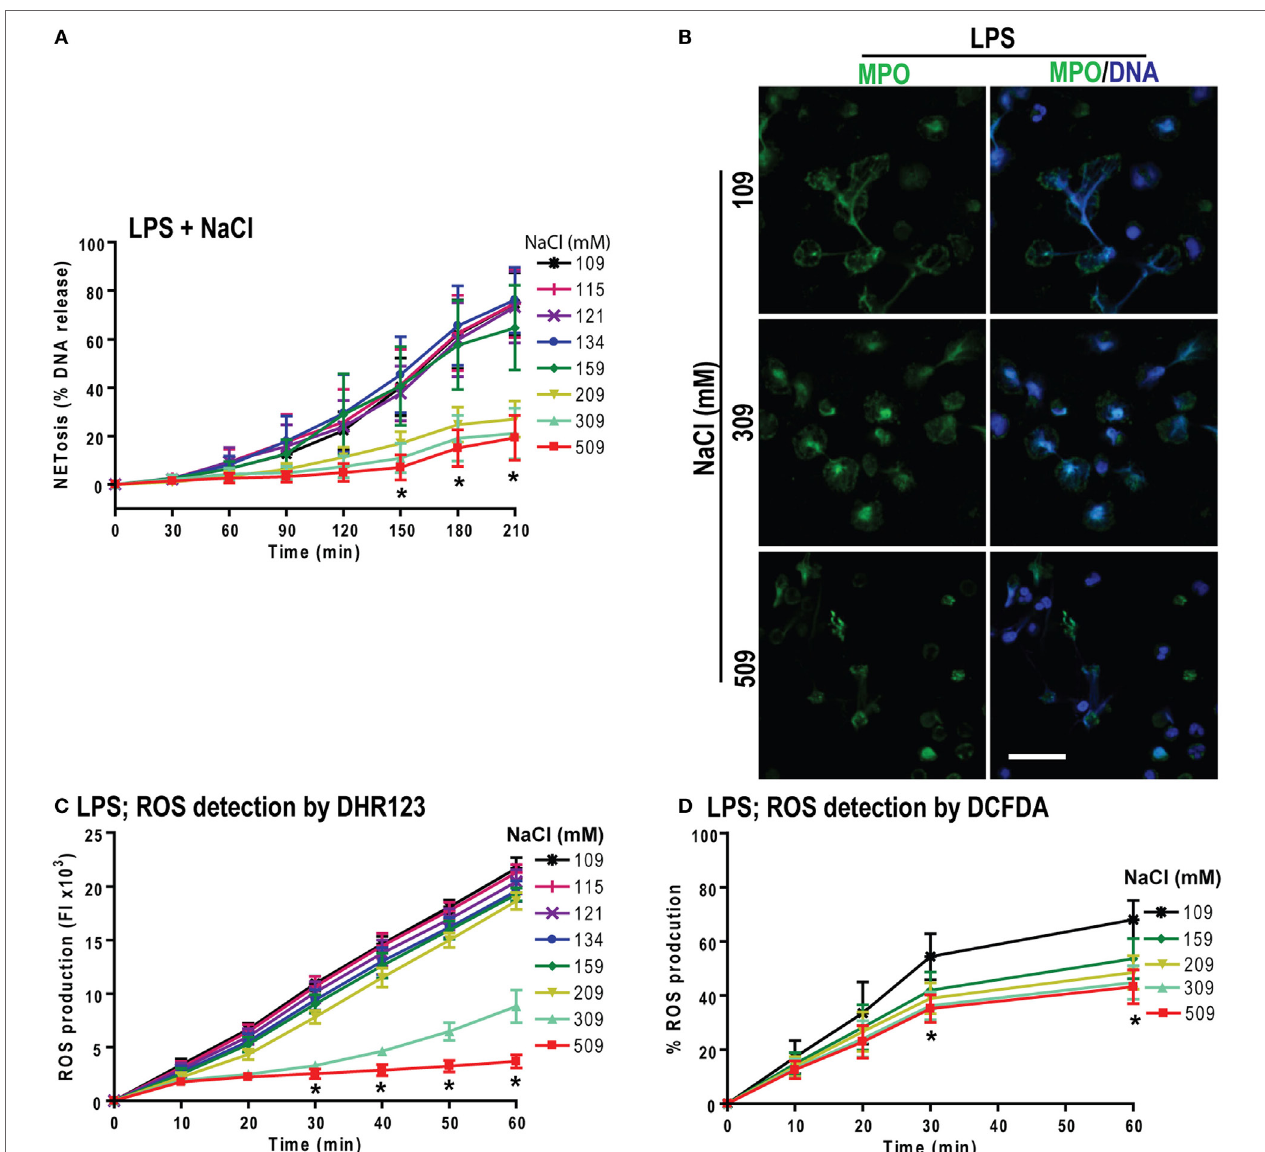
FigUre 5 | Increasing NaCl concentration suppresses lipopolysaccharide (LPS)-mediated reactive oxygen species (ROS) production and NETosis. (a) % total DNA release (NETosis) of LPS-treated neutrophils are significantly suppressed at higher NaCl concentrations. The suppression is significant in high salt concentrations (209, 309, and 509 mM) at various time points ( n = 3 − 5; * p < 0.05; two-way ANOVA with Bonferroni’s multiple comparison post test). (B) Confocal microscopy of neutrophils shows significant LPS-induced NETosis suppression at hypertonic saline concentrations compared to lower salt dose treatments ( n = 3 − 4; myeloperoxidase, green; DNA, DAPI blue; scale bar, 22 µm). (c,D) LPS-induced ROS production measured by DHR123 and DCFDA dyes, using fluorescent plate reader show the ROS suppression in LPS-treated neutrophils at high NaCl concentrations over 60 min ( n = 3 − 5; * p < 0.05; two-way ANOVA with Bonferroni’s multiple comparison post